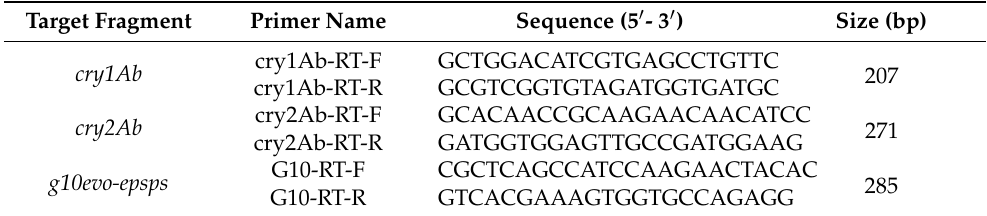
Table 1. Primers used for RT-PCR analysis.